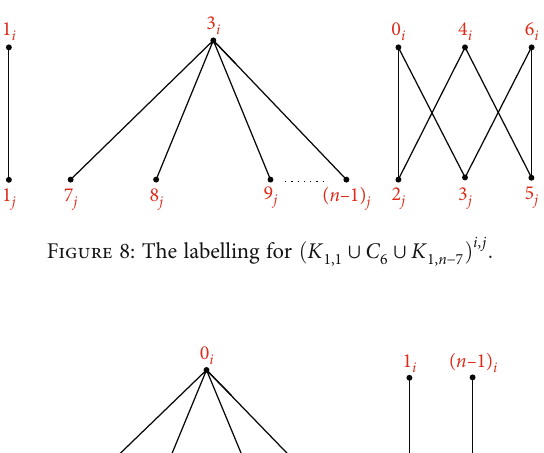
i , j : ∪ K 1,1 1, n − 2 Þ